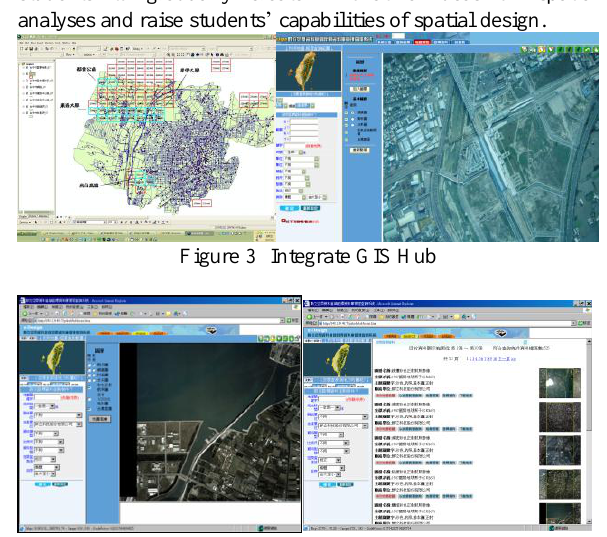
Figure 4 GIS Hub for preview the search result of spatial data